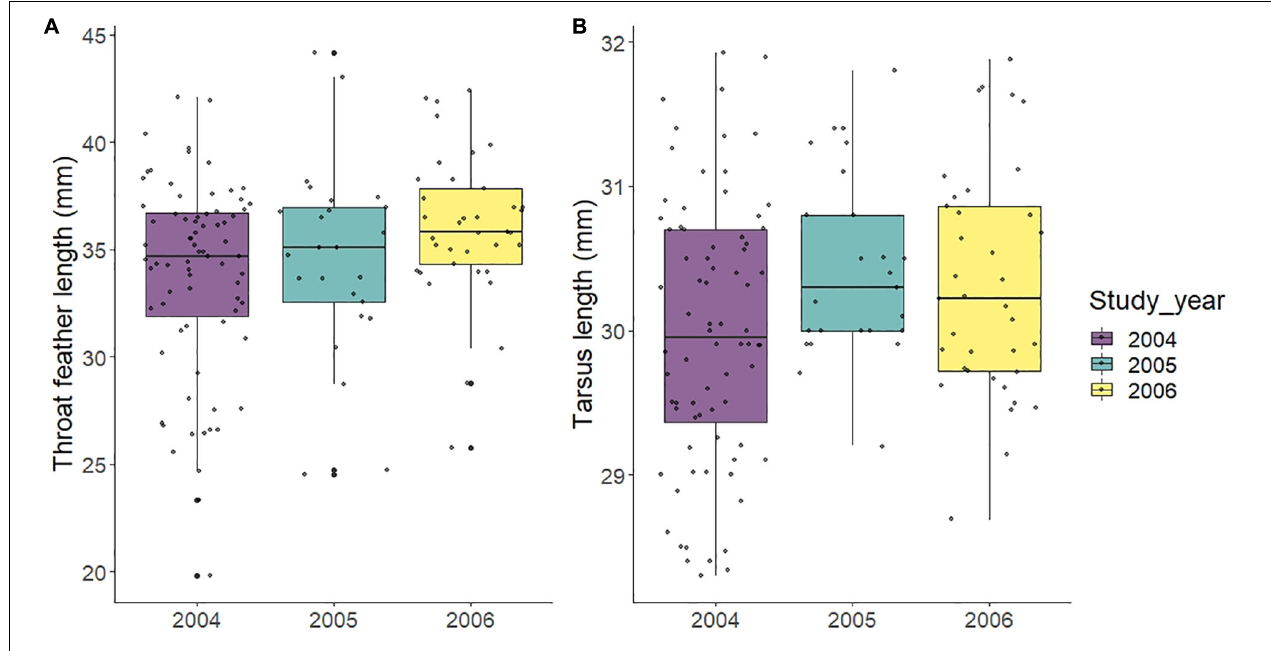
FIGURE 2 | Changes in male throat feather length (A) and tarsus length (B) across the 3 years of study. For the analysis and the figures, we took only one measurement per male. In case of males sampled in multiple years, only the first year was